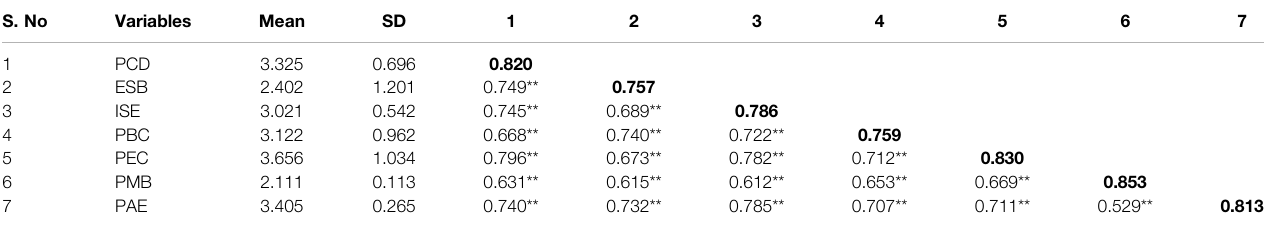
TABLE 2 | Mean, standard deviation, and discriminant validity using Fornell and Larcker ’ s criterion. S. No